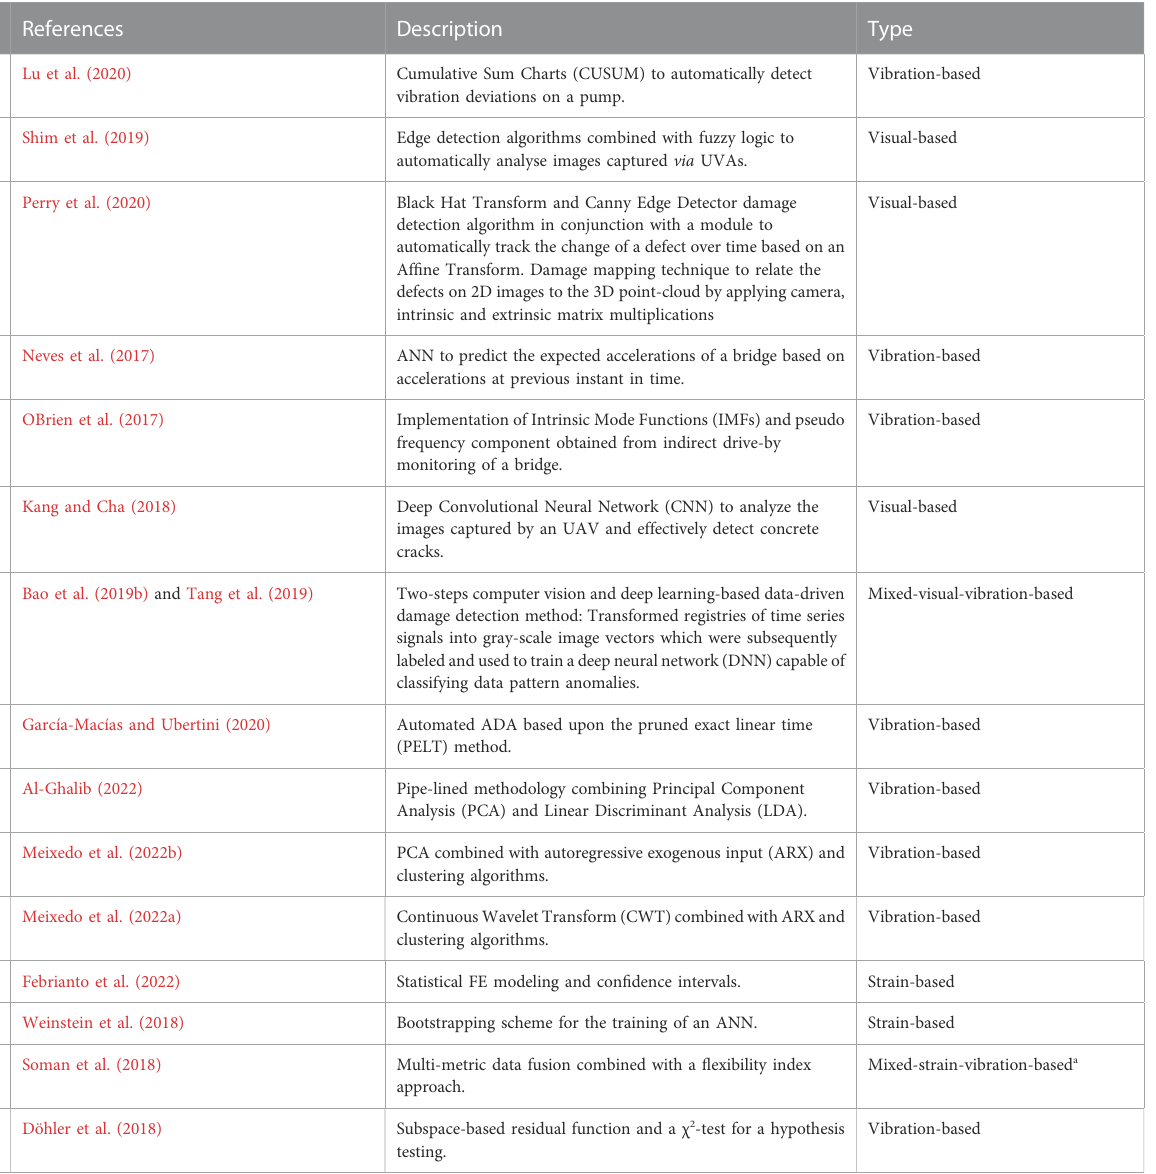
TABLE 3 Various ADAs found on the works included in this systematic